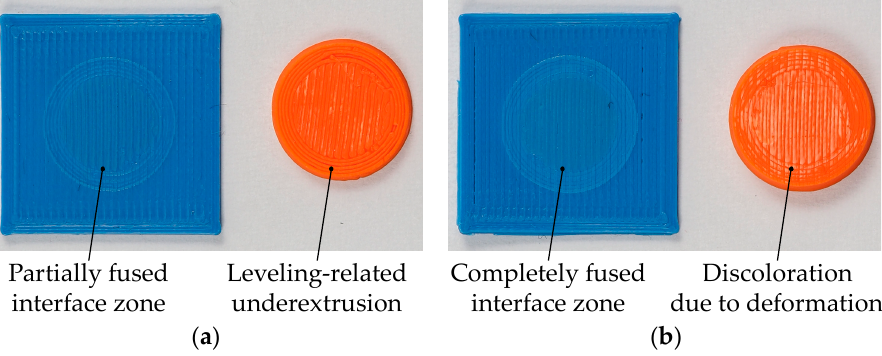
Figure 6. Difference between a badly leveled ( a ) and a well-leveled ( b ) interface zone for the combination of PLA (blue) and ABS (orange).